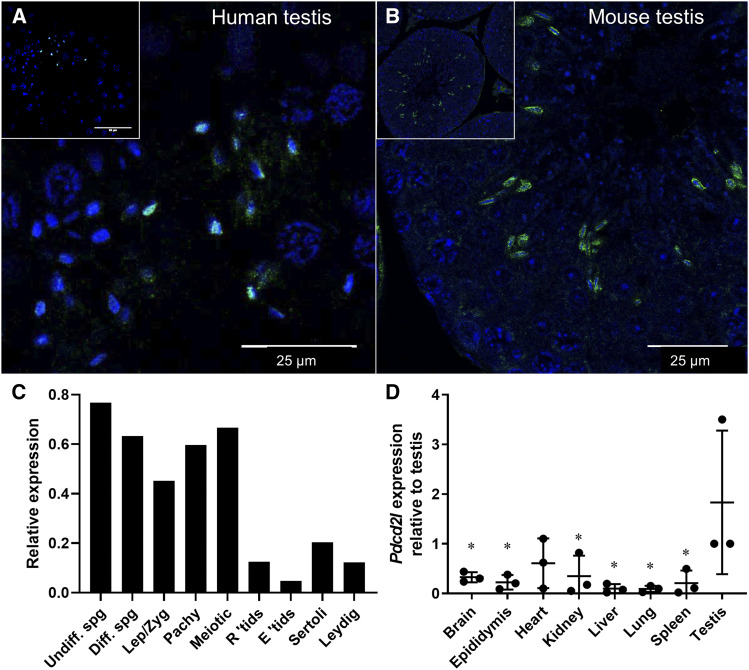
PDCD2L testis localization and tissue expression. PDCD2L immunolocalisation was explored in (A) human and (B) mouse testis. Pdcd2l transcript levels were retrieved from a mouse single cell testis sequencing database (C) and were measured via qPCR across major body organs (D). * P < 0.05 compared to testis. Undiff. spg = undifferentiated spermatogonia, Diff. spg = differentiated spermatogonia, Lep/Zyg = leptotene/zygotene spermatocytes, Pachy = pachytene spermatocytes, R ‘tids = round spermatids, E ‘tids = elongating spermatids.